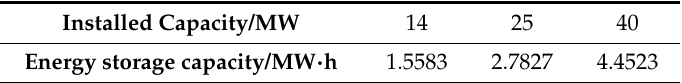
Table 3. Energy storage capacity allocation results under different installed